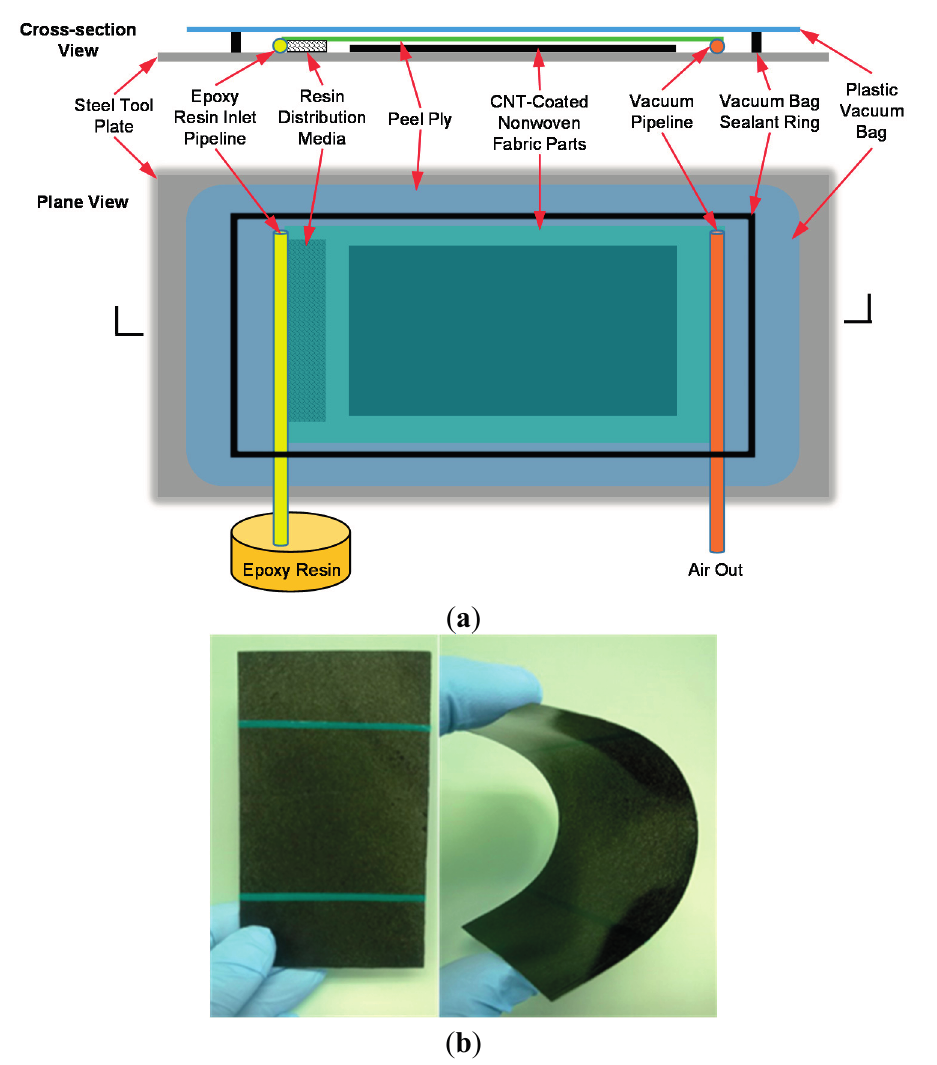
Figure 2. ( a ) Schematic diagram of the VARTM process utilized to infuse epoxy resin into the nonwoven fabric to form the CNT composite sensors and ( b ) photograph showing a free-standing CNT sensing composite after curing the epoxy, showing its